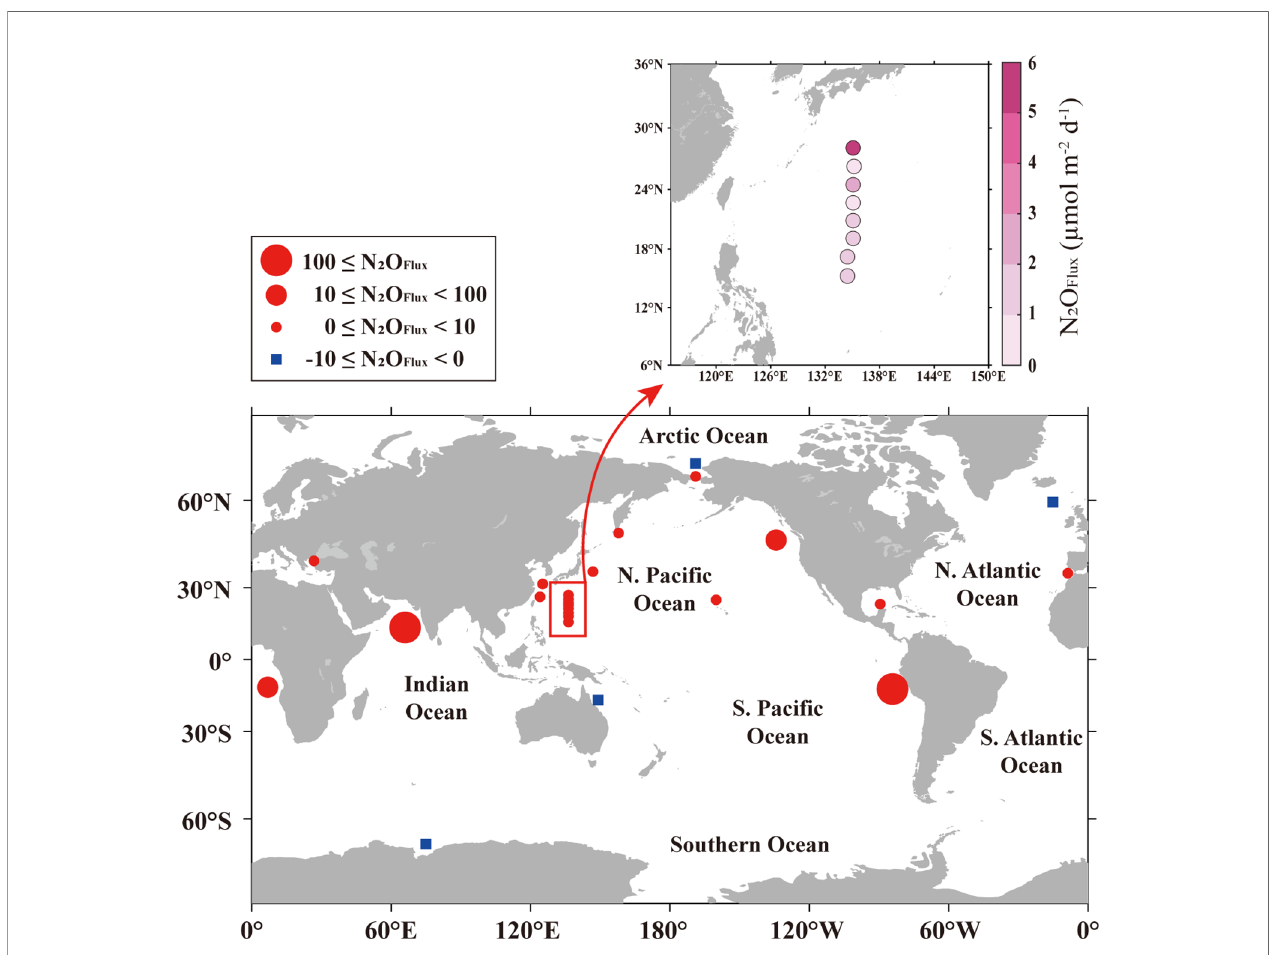
FIGURE 4 | Spatial distribution of STWNPO surface N 2 O fl uxes across the air – sea interface during the investigation (spring, 2020) and N 2 O fl uxes from various regions. The points encompassed by the red box represent the current study area. The N 2 O fl ux values of different regions are given in Supplementary Table S8